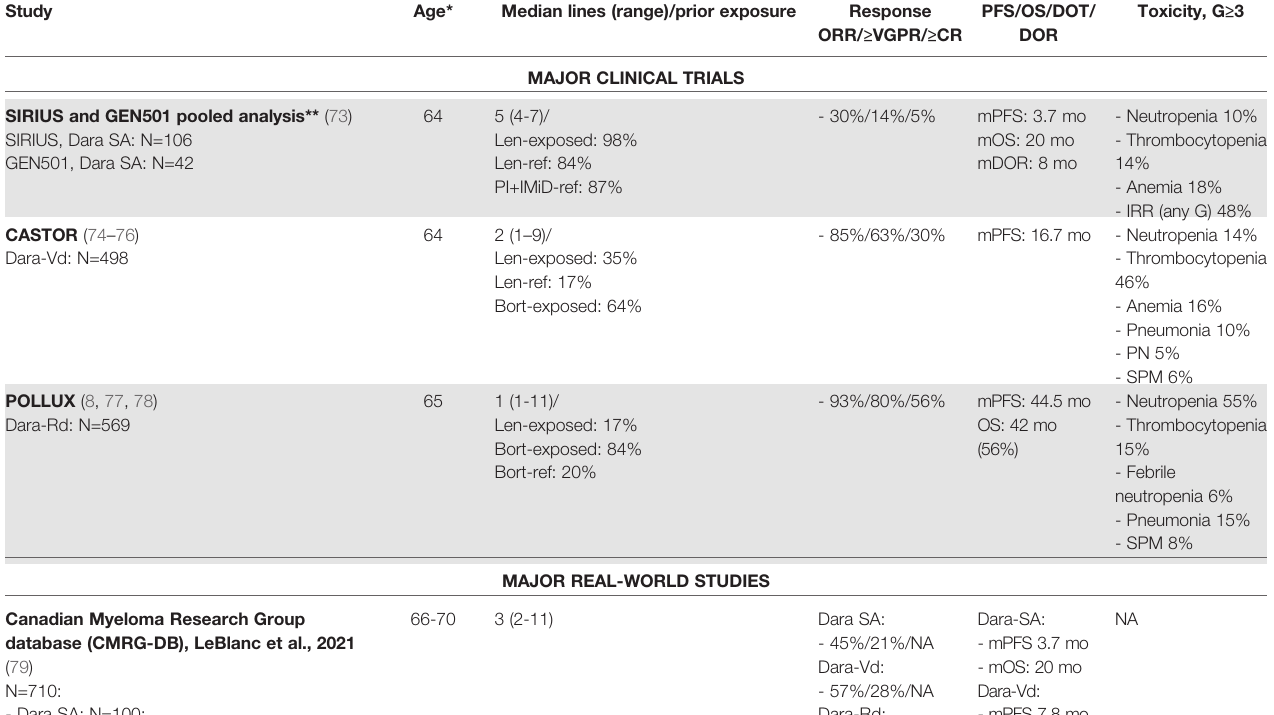
TABLE 5 | Major clinical trials and real-world studies based on daratumumab for the treatment of RRMM.